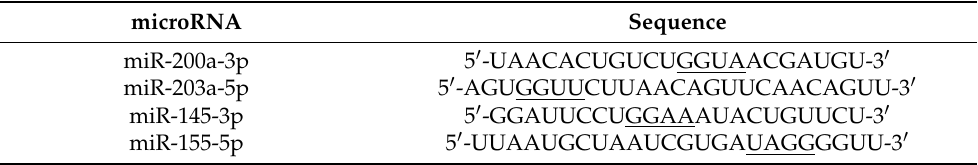
Table 2. Nucleotide sequences of microRNAs that were used for SPR studies. The potential NUCB1- A binding motif (GG A ) is underline. U U